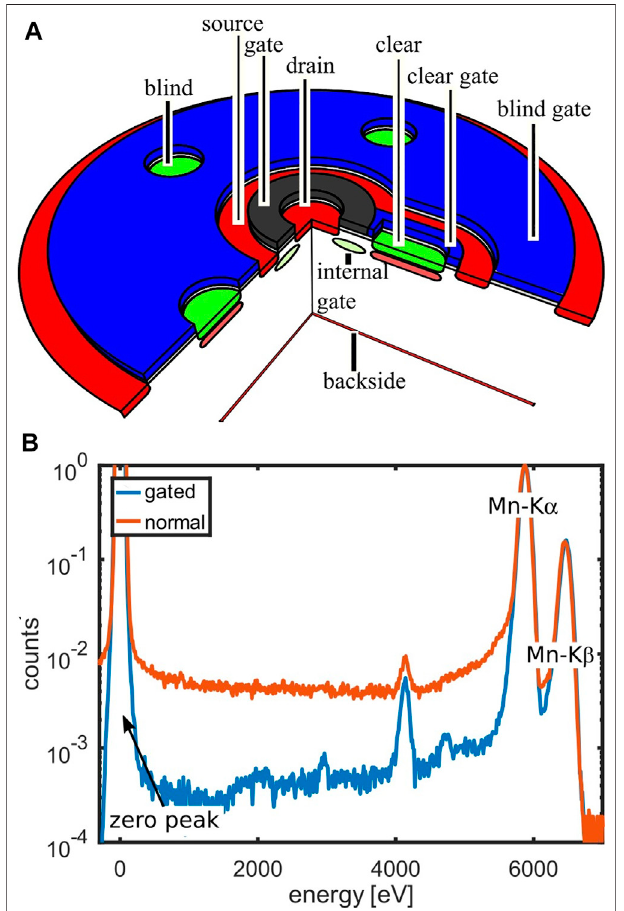
FIGURE 8 | (A) shows the so called gateable DePFET consists of a DePFET (here with circular geometry) surrounded by a large MOS structure (blind gate) and n + contacts (blind) that allow to prevent charge collection inside the DePFET itself [26]. This electronic shutter can be used to suppress charge collection and prevent for example out of time events. The suppression of charge collection can be used to prevent charge collection during the readout. This improves especially the peak to background of DeFPET sensors as shown in (B) [26].